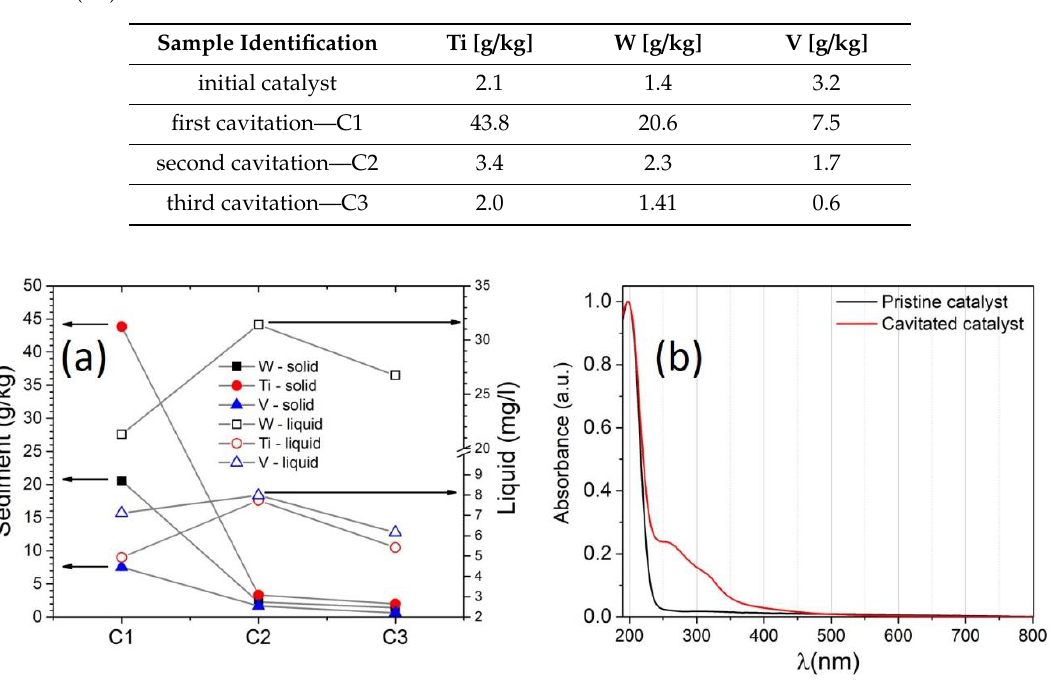
Figure 8. ( a ) The evolution of W (black squares), Ti (red circles), and V (blue triangles) in the sediments (solid fill) and liquid (no fill) as determined by inductive coupled plasma—optical emission spectroscopy; ( b ) UV–vis of the pristine catalyst and the cavitated catalyst.